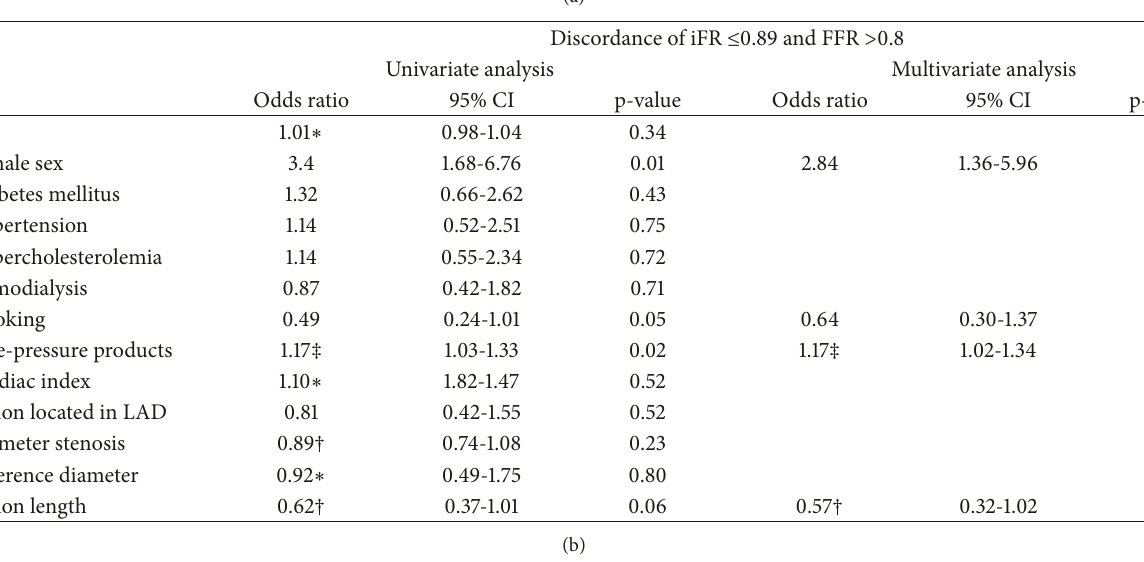
Table 4: Univariate and multivariate analysis to evaluate predictors of discordance between iFR and FFR.